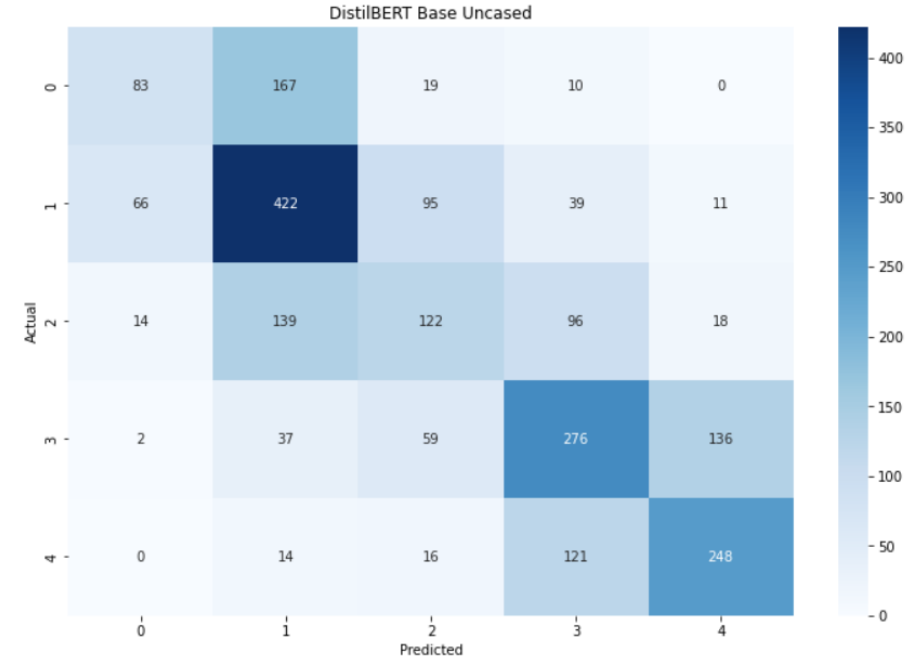
Figure 14. Confusion matrix for DistilBERT BASE